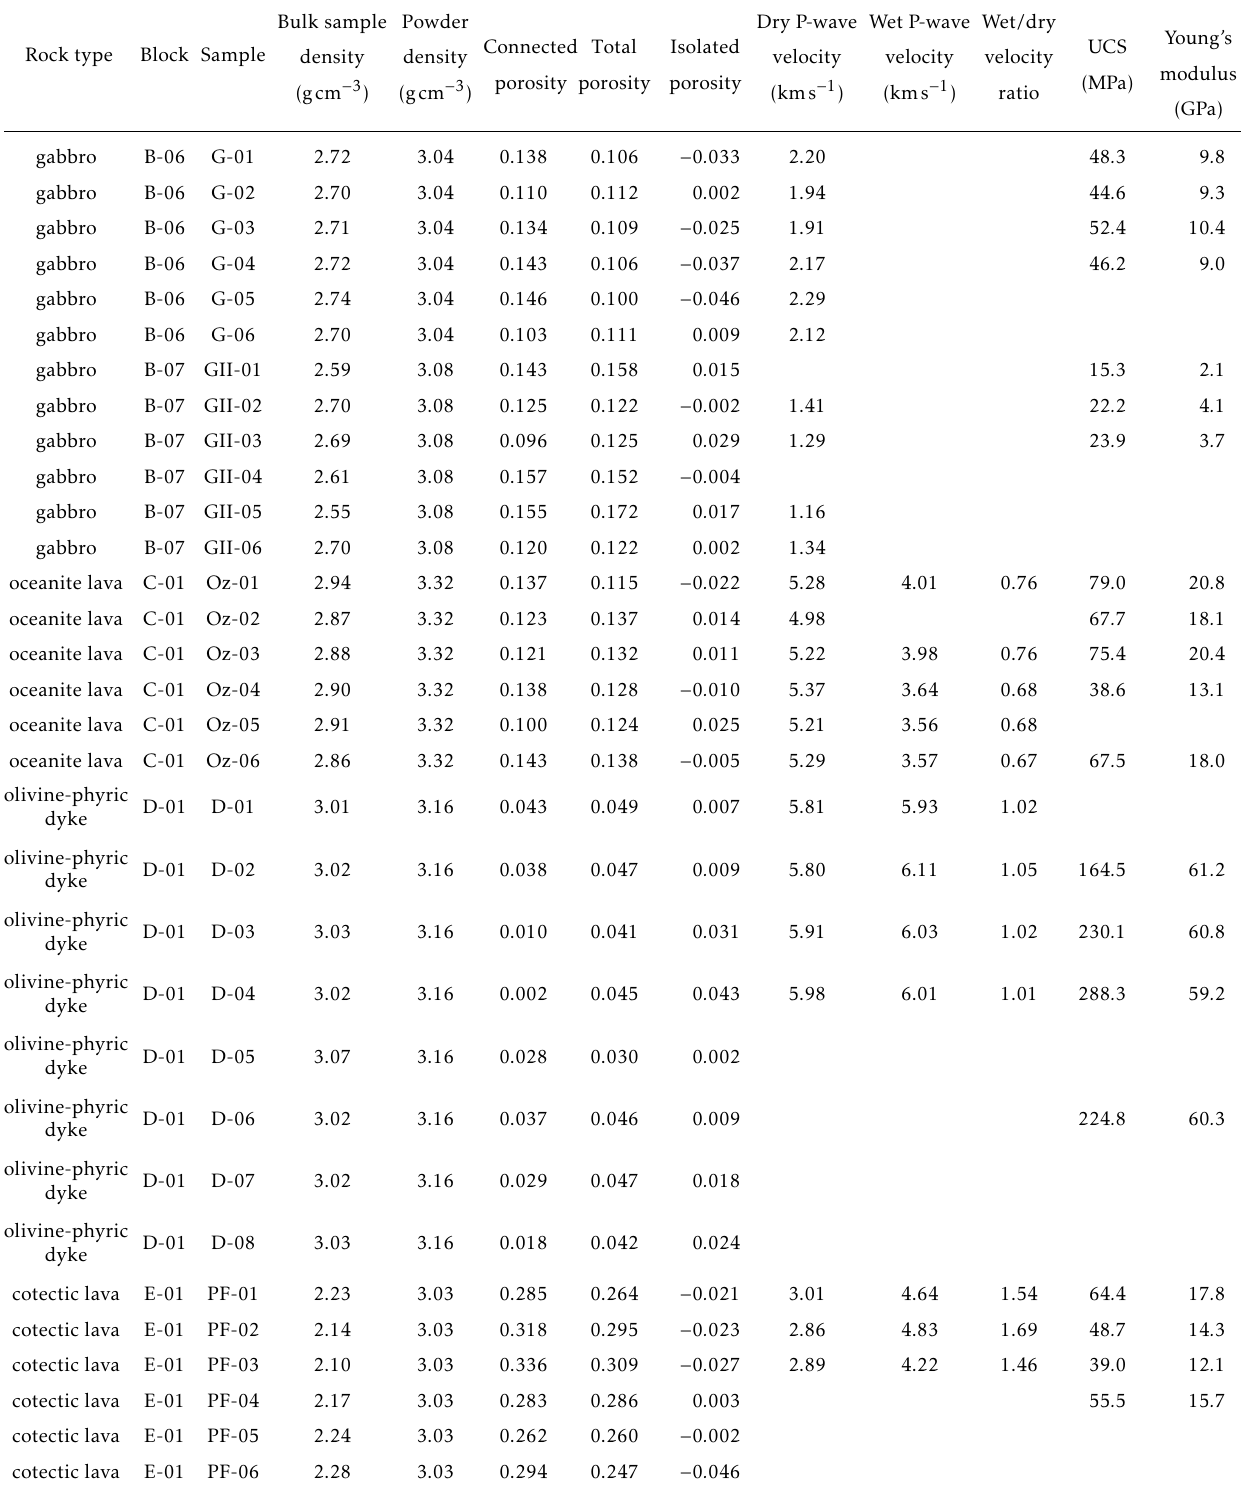
Table A1 [cont.]: Summary of the rock physical property measurements for the samples collected from Piton de la Fournaise (France) for this study. UCS – uniaxial compressive